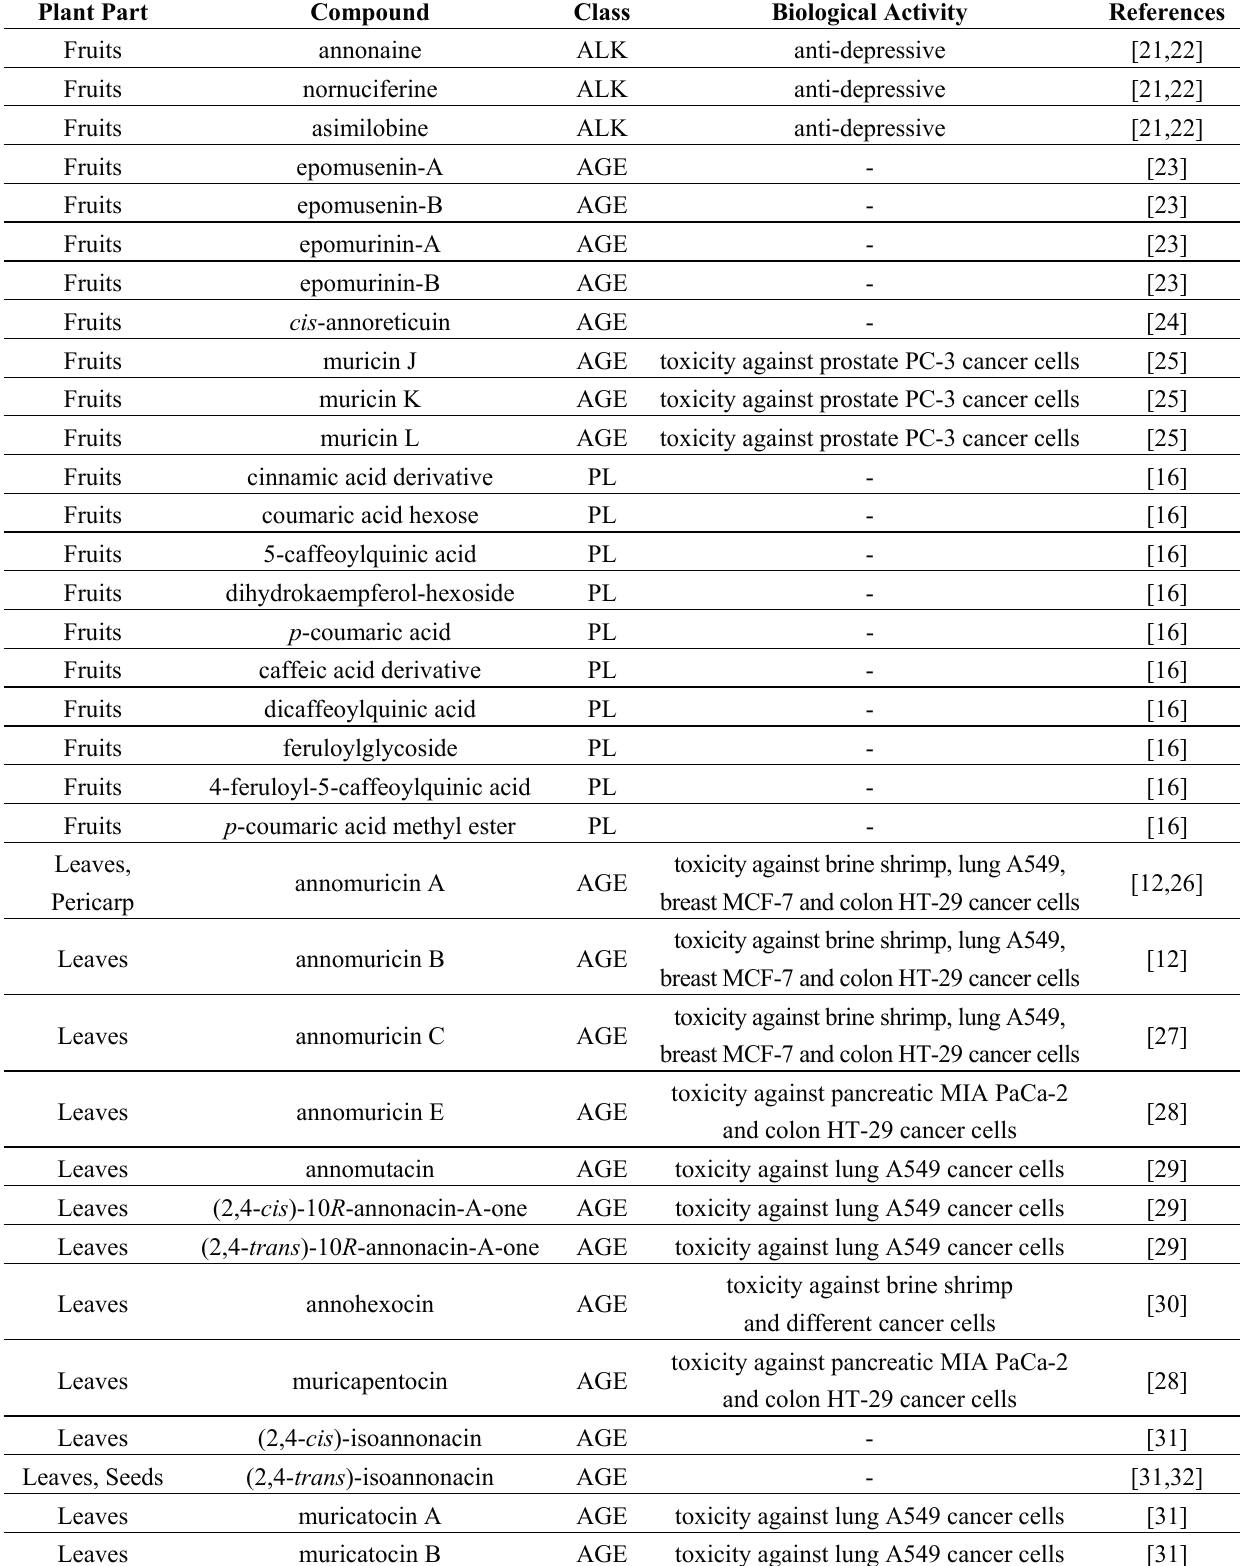
Table 1. Chemical compounds isolated from Annona muricata . ALK: alkaloid; AGE: annonaceous acetogenin; MG: megastigmane; FTG: flavonol triglycoside; PL: phenolic; CP: